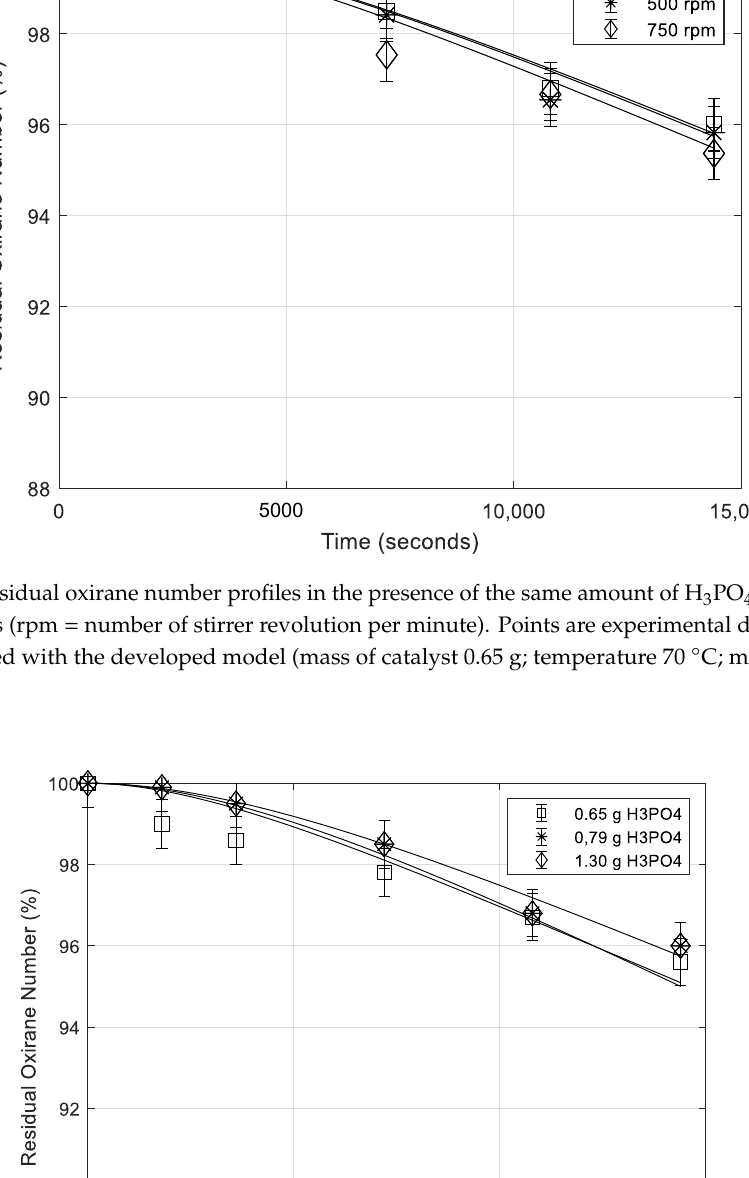
Figure 7. Residual oxirane number profiles for different temperatures. All the other conditions are the same (mass of catalyst 0.65 g; rate of agitation 500 rpm; mass of formic acid 5.16 g). Points are experimental data lines that are calculated with the developed model.